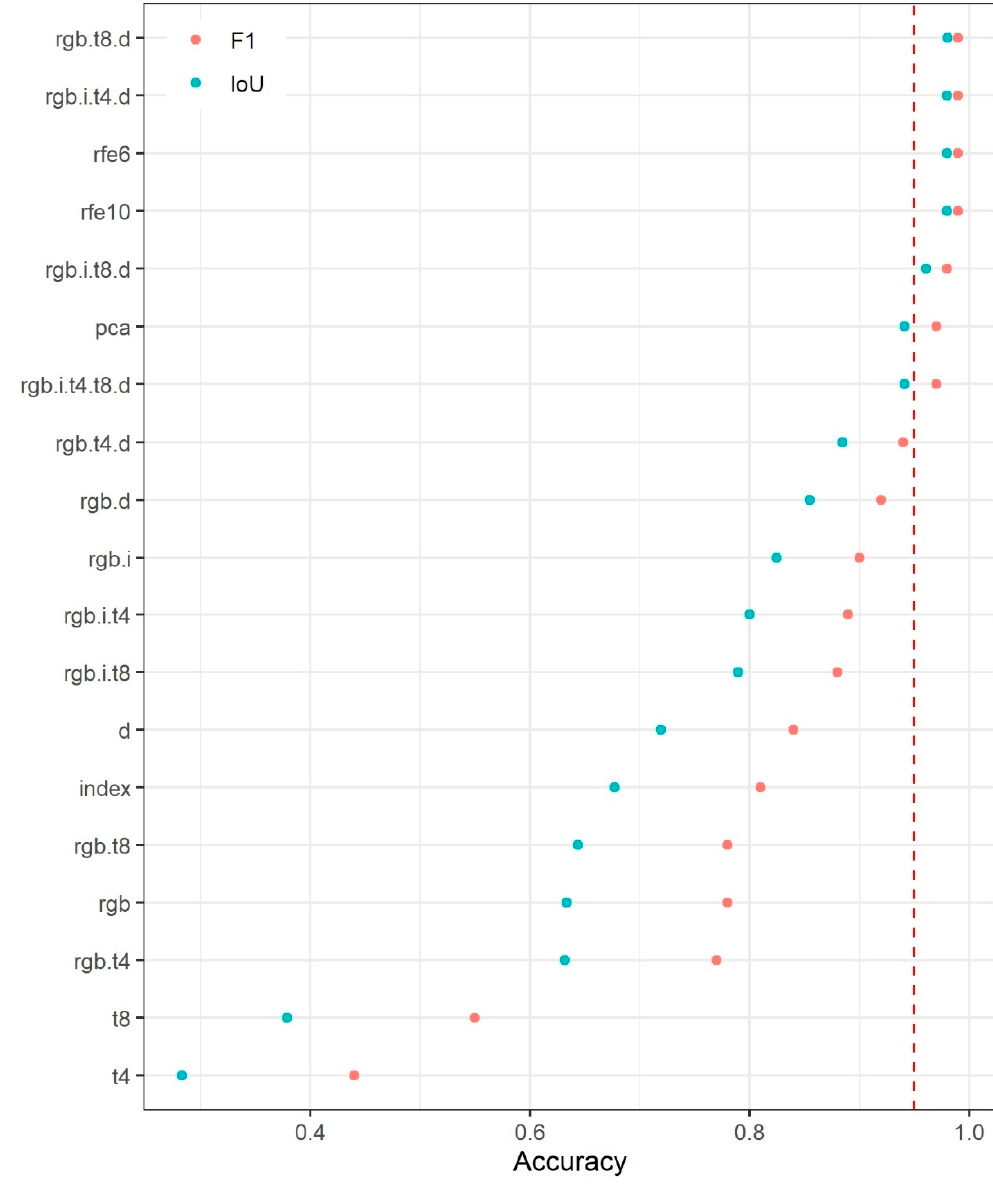
Figure 8. F1-values based on the maps generated by RF models and the independent test dataset (input variables: rgb: visible bands; i: RGB indices, t: texture information, pca: principal components, d: morphometric indices, rfe: selected variables with recursive feature elimination; dashed red line: accuracies >95%).